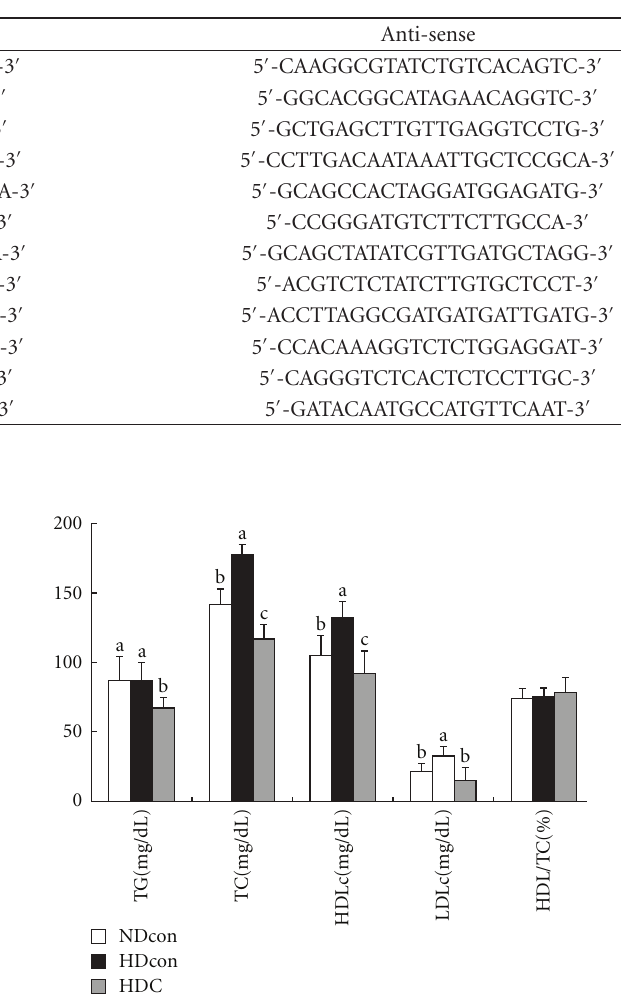
Figure 1: Serum lipid concentrations. Values are means ± SD. Values with di ff erent superscript letters (a, b, c) indicate significant di ff erences among groups at P < . 05 by Duncan’s multiple range